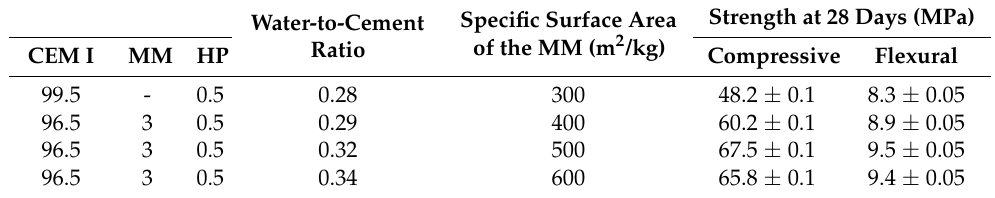
Table 10. Influence of the fineness of grinding of MM on the strength of CB.